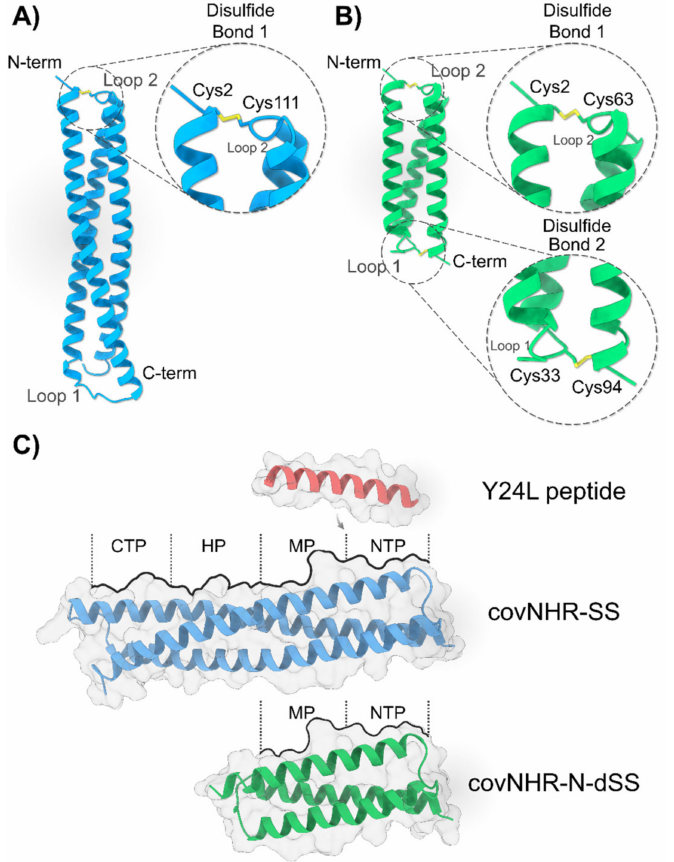
Figure 1. Design of covNHR miniproteins. ( A , B ) Ribbon models of covNHR-SS ( A , blue) and covNHR-N-dSS ( B , green) showing the location of the residues chosen for mutations to form disulfide bonds. Cysteines are shown in sticks and colored in yellow. ( C ) Model of the structure of the proteins and peptides involved in this study depicted in molecular surface and colored green (covNHR-N- dSS), blue (covNHR-SS) and red (Y24L peptide, gp41 residues 638–661). CovNHR is a highly accurate mimic of the full trimeric gp41 NHR coiled-coil, as such, its binding surface is also composed of four different hotspots: CTP (C-terminal Pocket), HP (Hydrophobic Pocket), MP (Middle Pocket) and NTP (N-terminal Pocket), see details in the